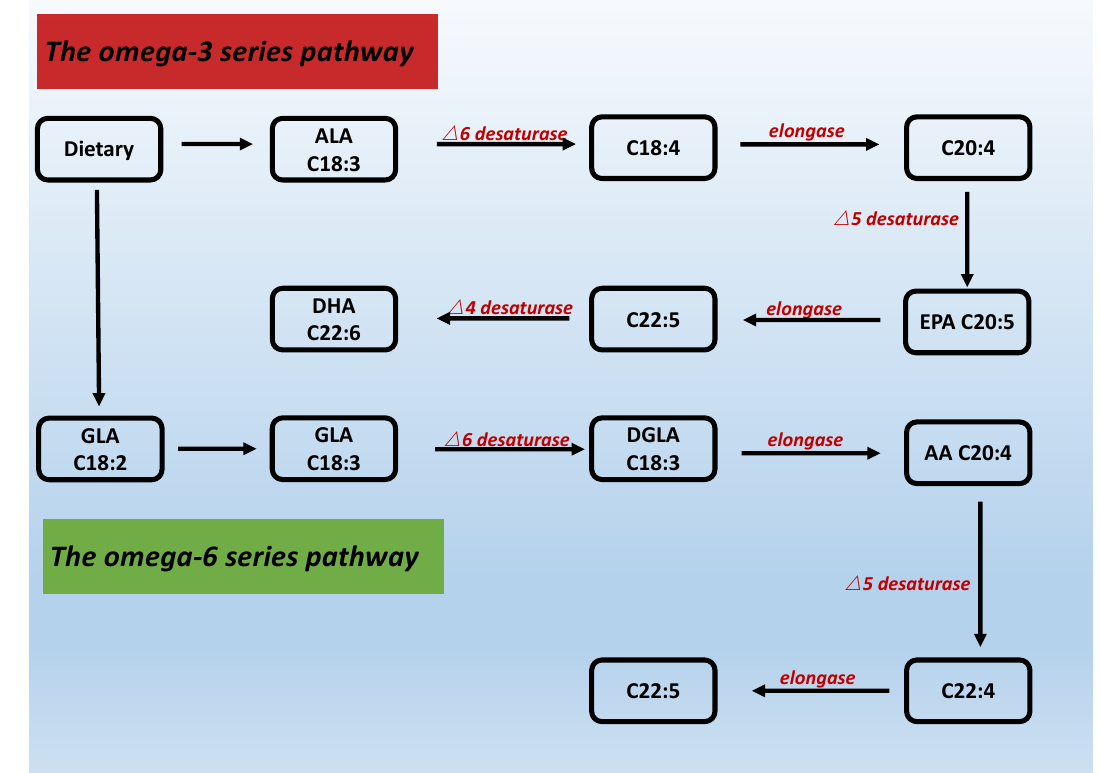
Figure 1. The pathway of polyun-saturated fatty acids n-3 and n-6